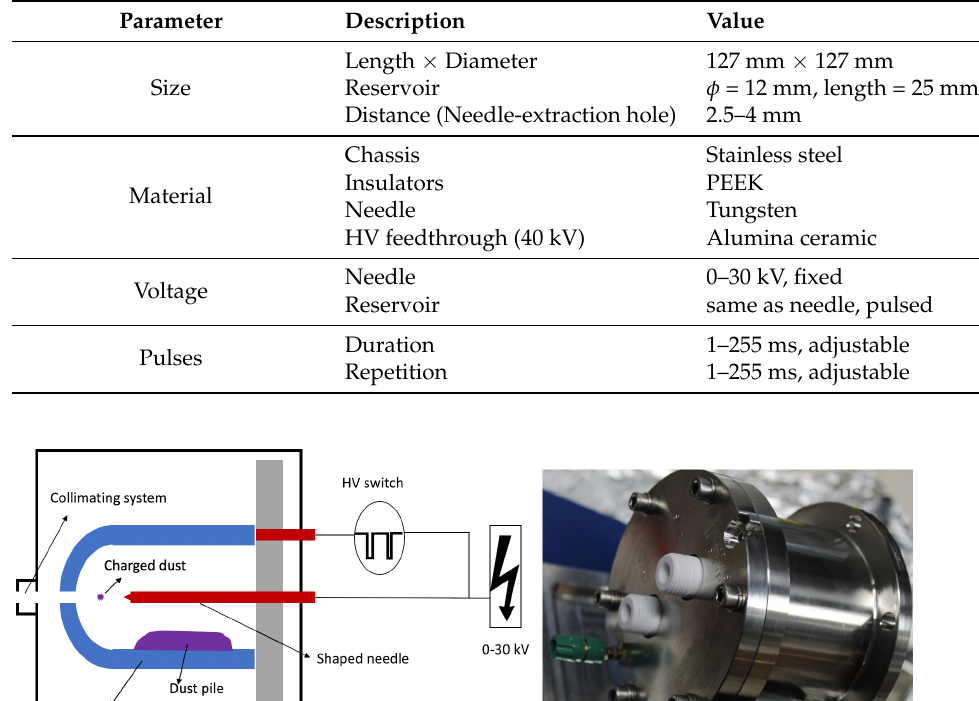
Table 2. Parameters of the upgraded dust source.